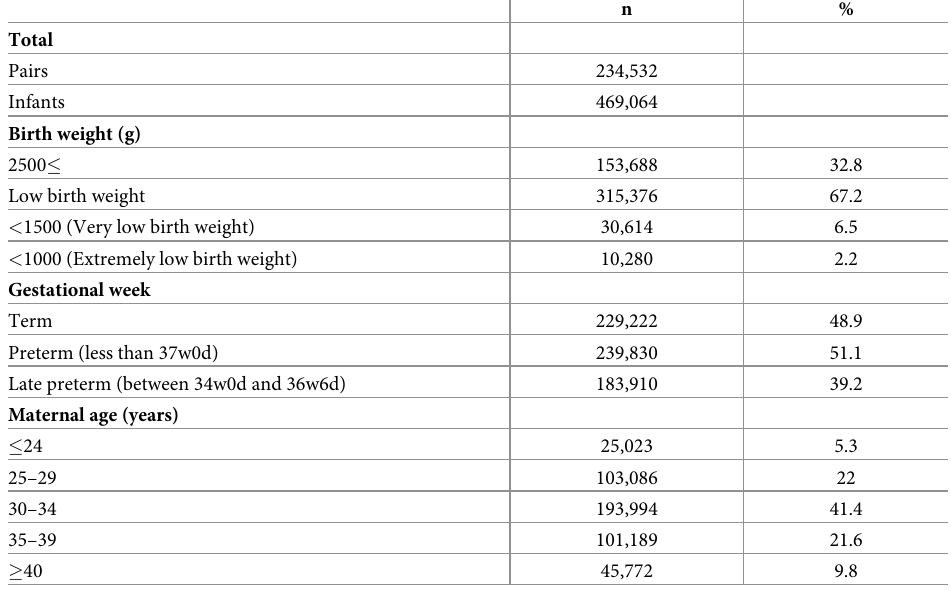
Table 1. Main characteristics: Maternal and fetal